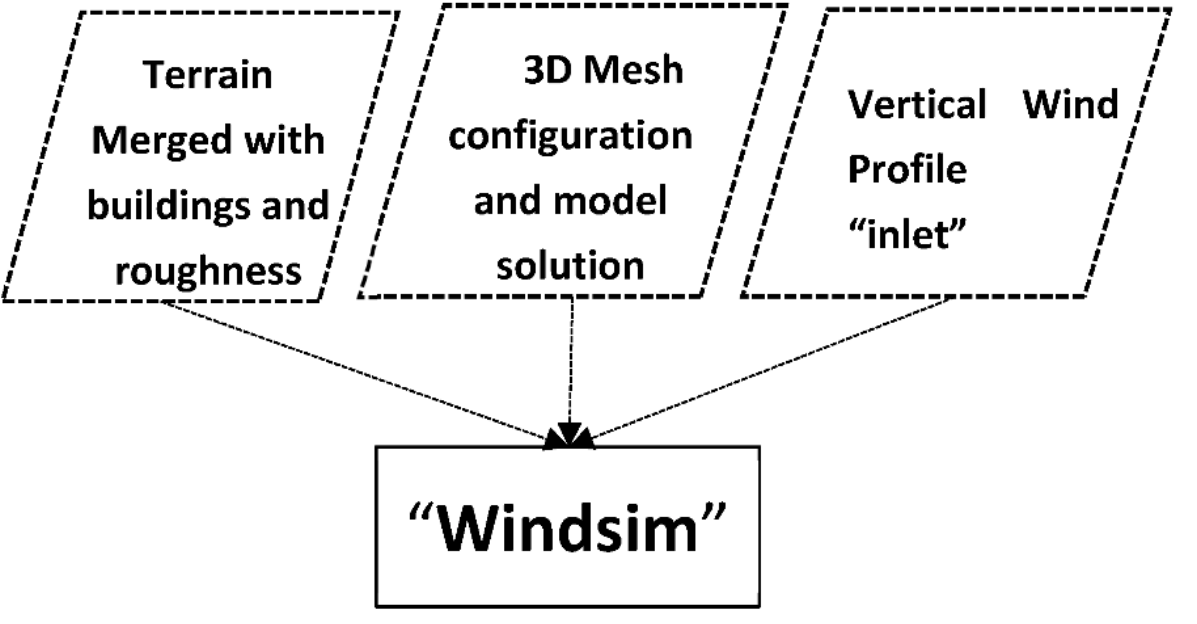
Figure 5. Schematic workflow for performing a simulation with the WindSim model.